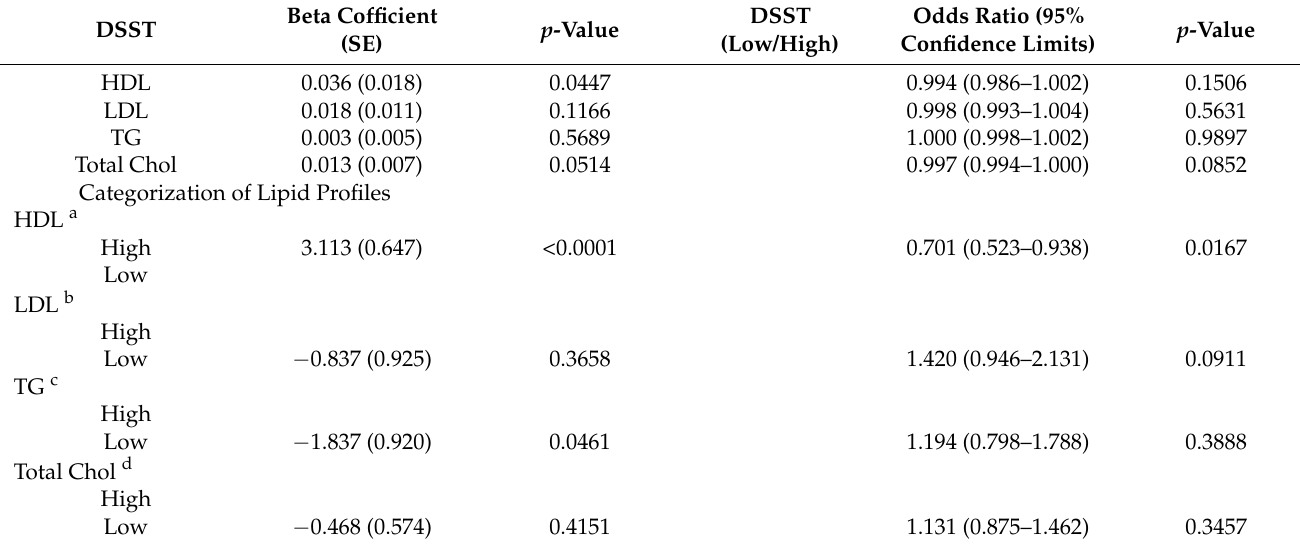
Table 4. Multiple linear regression and logistic regression analysis of the association between lipid profiles and